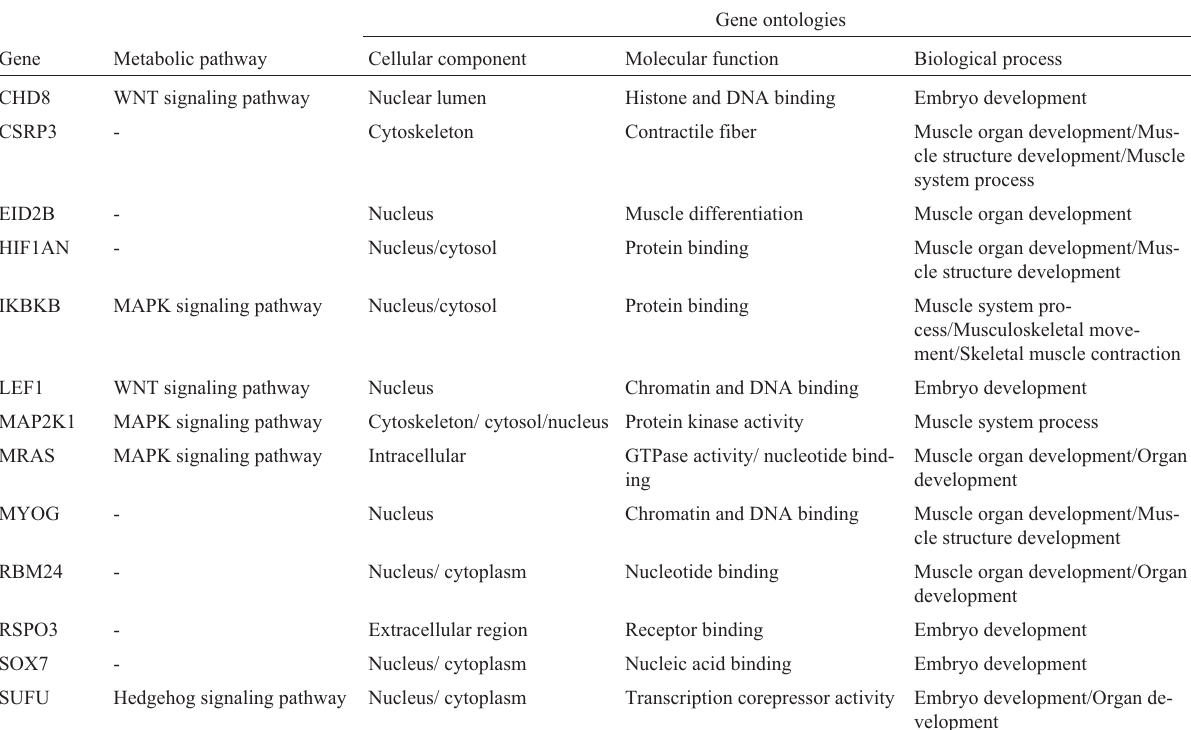
Table 2 - Metabolic pathways and gene ontologies for genes represented in the gene network.